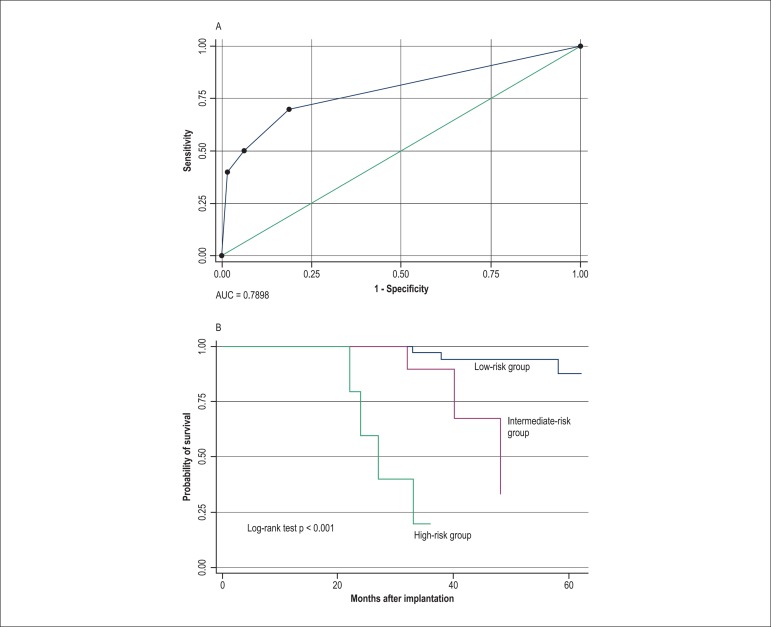
A: ROC curve of the model at time 3 (2nd year), with the variables right
ventricle (RV) dysfunction and functional class (FC) III and IV compared with I
and II, with an area under the curve (AUC) of 0.789, sensitivity of 40%,
specificity of 98.4% and accuracy of 90.5%. B: Kaplan-Meier curve showing that
the absence of the variables RV dysfunction and FC III / IV (Class A - low
risk) indicates an event-free rate of 97.5% at 30 months.